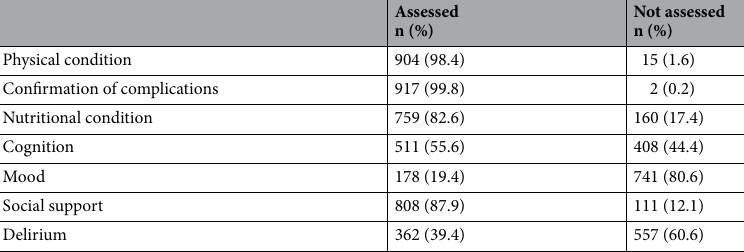
Table 4. Questions regarding the implementation of each preoperative evaluation item. We asked respondents to indicate whether participants performed the following assessments before surgery: (1) physical condition; (2) confirmation of complications; (3) nutritional condition; (4) cognition; (5) mood; (6) social support; and (7) delirium. (Multiple responses